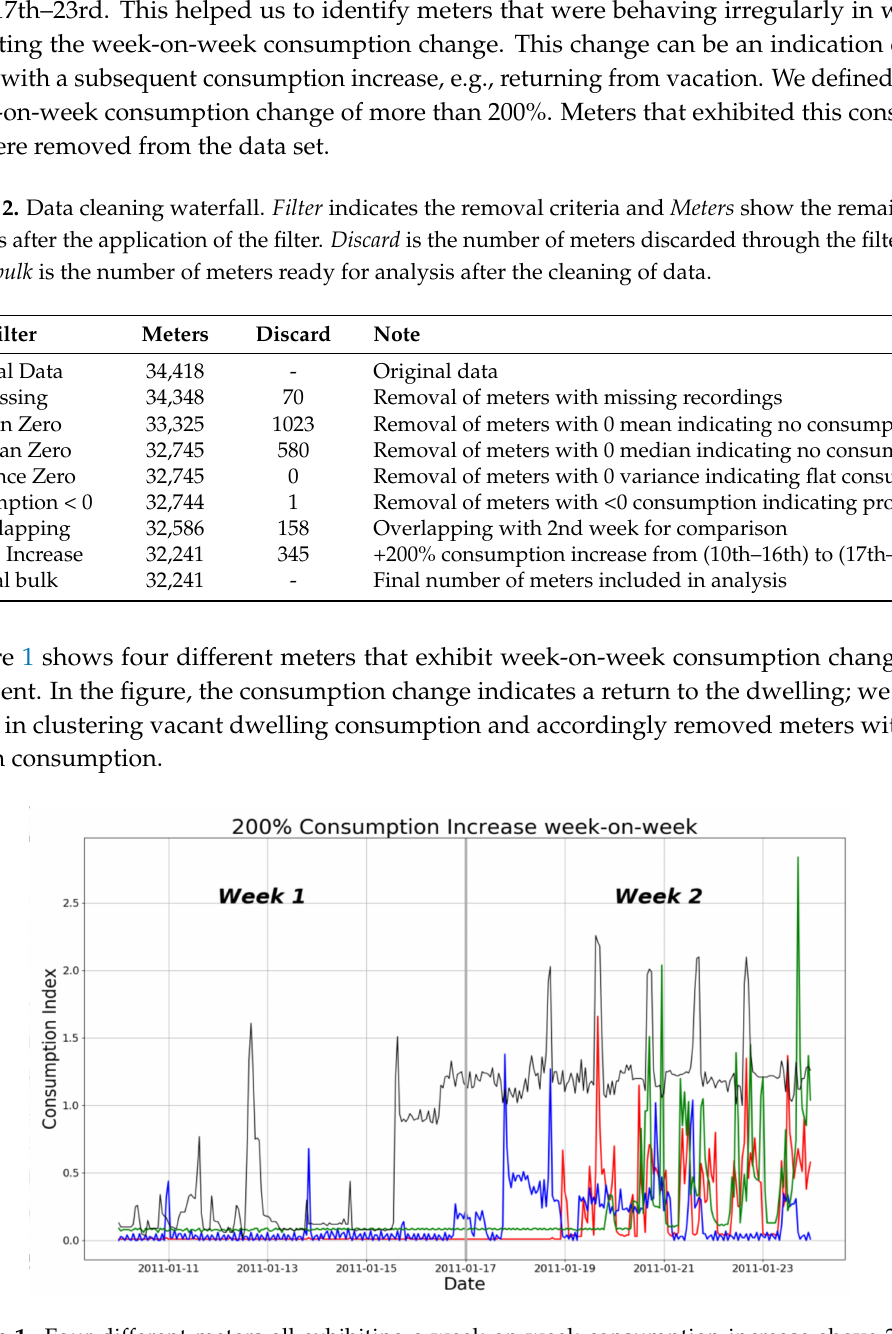
Figure 1. Four different meters all exhibiting a week-on-week consumption increase above 200%. This is to filter out dwellings that were vacant during the week analyzed, as we were not interested in clustering standby